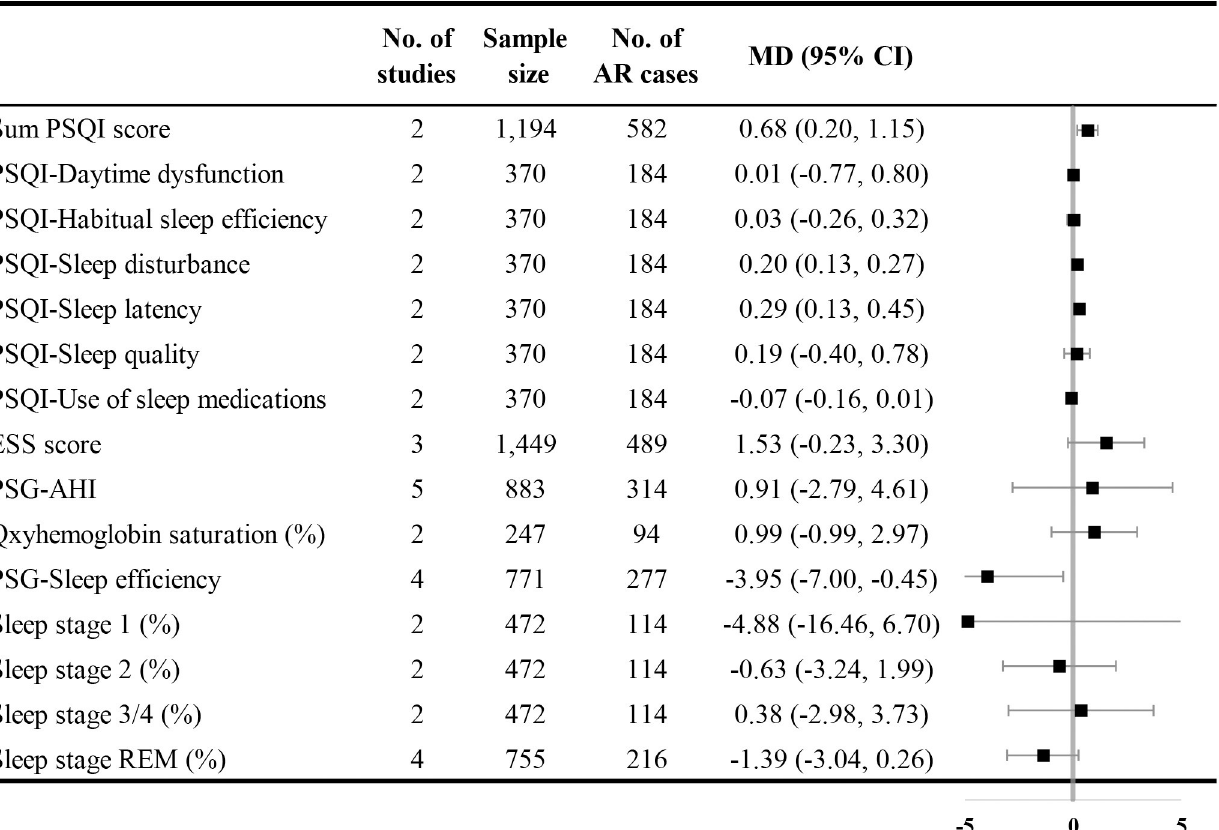
Fig 3. Comparative analysis of PSQI scale, ESS scale, and PSG outcomes. AHI: apnea-hypopnea index; ESS: Epworth Sleepiness Scale; PSQI: Pittsburgh Sleep Quality Index; REM: rapid eye movement.